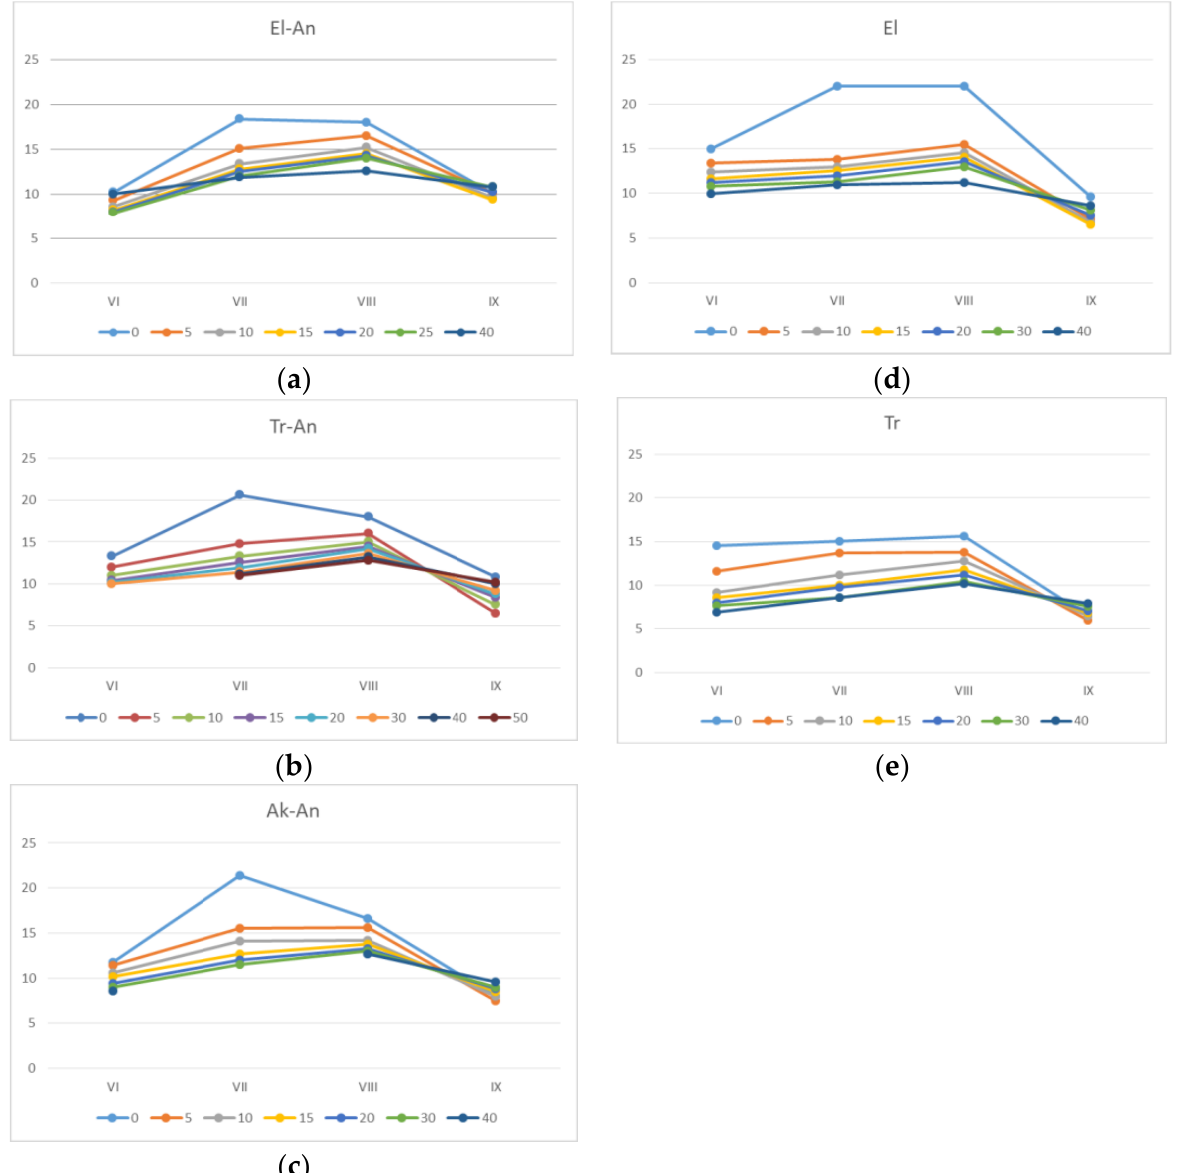
Figure 2. Soil temperature profiles at each 10 cm depth (°C) for topographical features of catena I, namely ( a ) El-An, ( b ) Tr-An, and ( c ) Ak-An, and for topographical features of catena II namely ( d ) El, and ( e ) Tr. The Roman numerals refer to the month of observations.